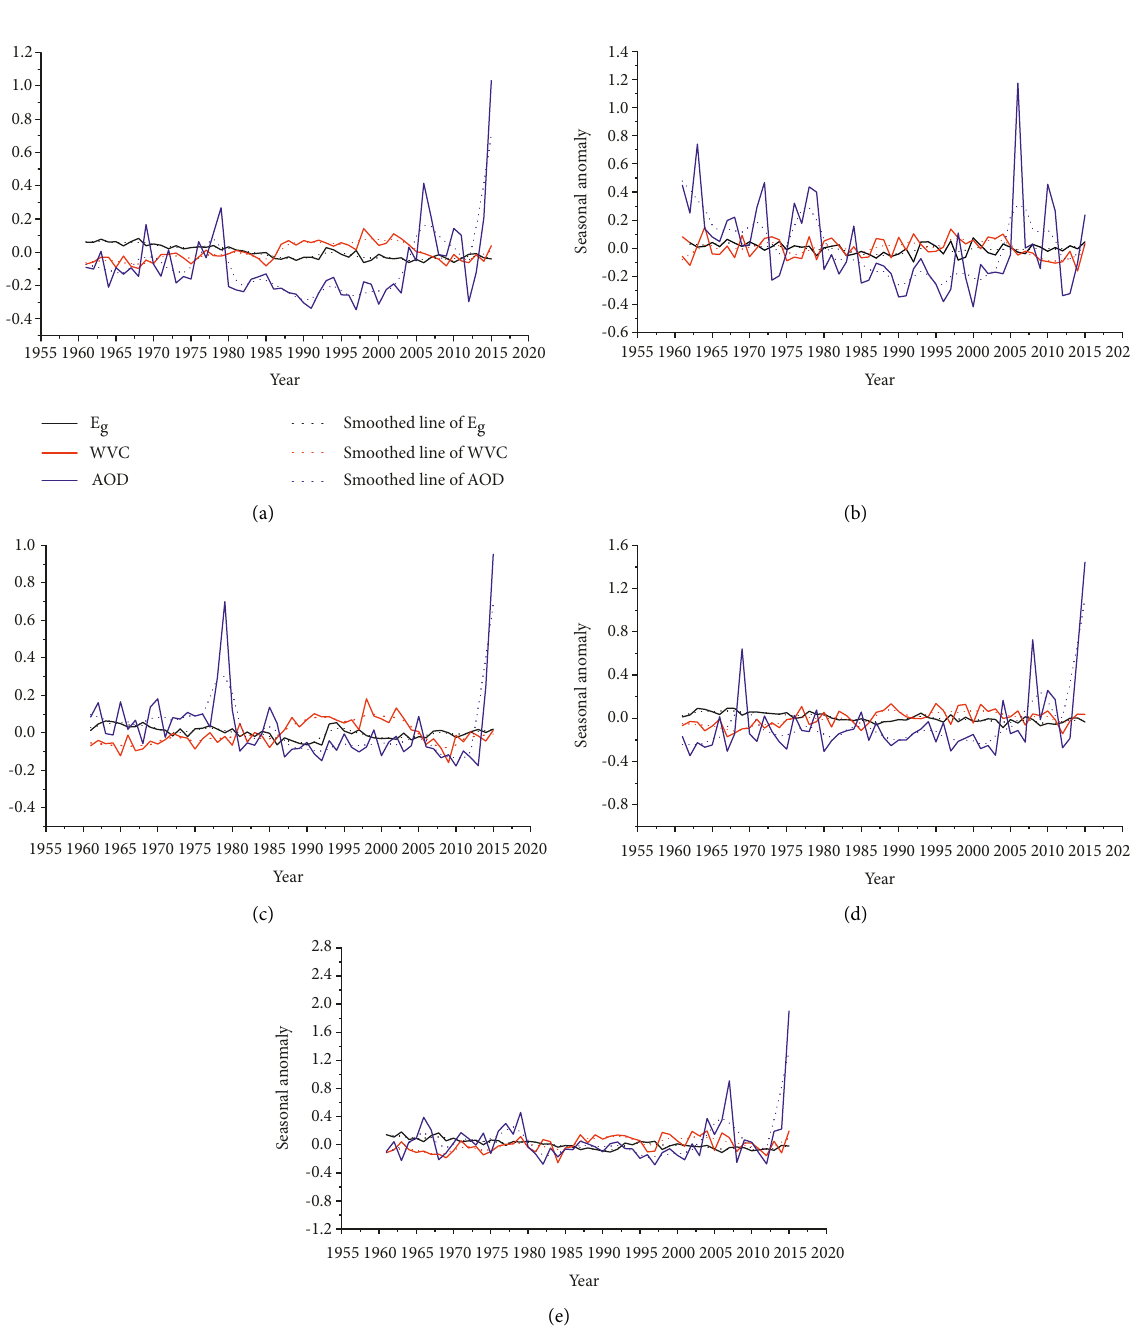
Figure 3: Interannual variations in anomalies of E g (black solid lines), WVC (red solid lines), and AOD (blue solid lines) smoothed (dashed lines) by using the Lowess algorithm. (a) Annual. (b) Spring. (c) Summer. (d) Autumn. (e)